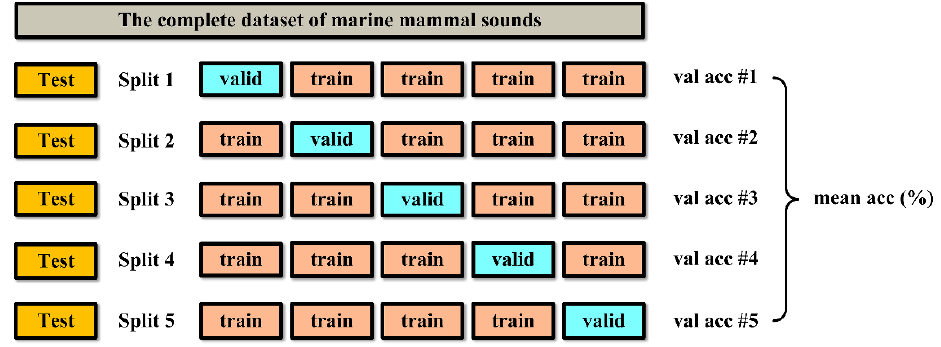
Figure 8. Segmentation method of data se